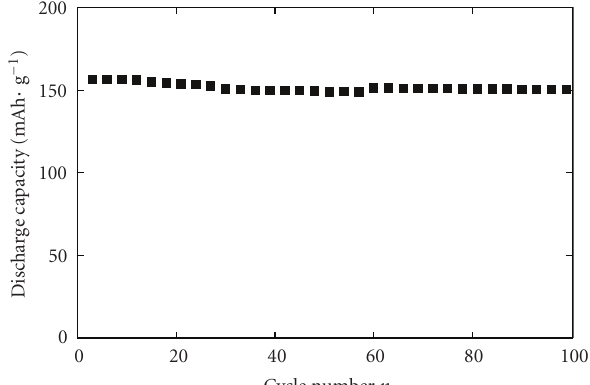
Figure 7: Relation between cycle number and discharge capacity of LiFePO 4 /C cathode at 50 ◦